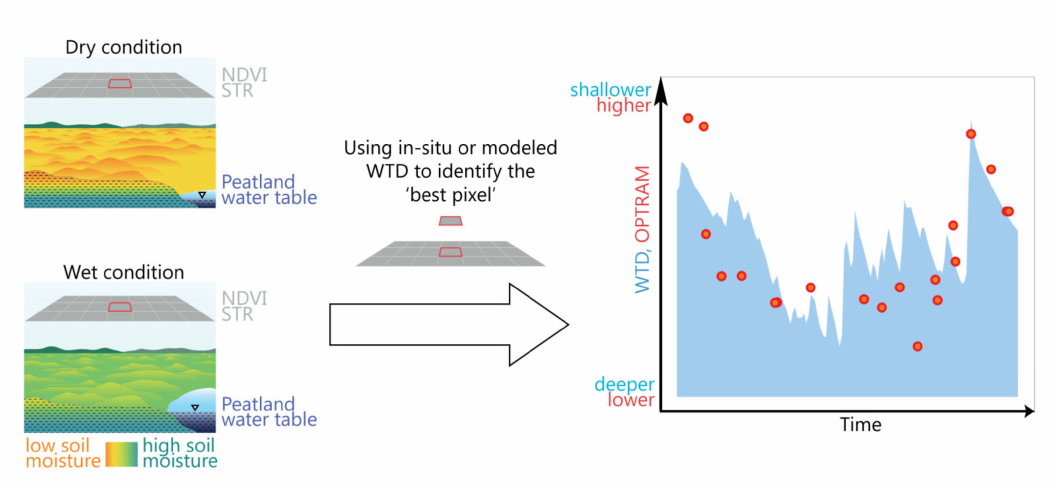
Figure 1. Schematic illustration of the approach proposed in this study. The ‘best pixel’ for the monitoring of water table depth (WTD) fluctuations with the OPtical TRApezoid Model (OPTRAM) index can be localized by WTD data either measured or modeled for a single location. The underlying assumption of this approach is that WTD fluctuations are synchronous in a peatland over several kilometers, while the spatial variability is mainly in the long-term mean value of WTD and the amplitude of fluctuations, both not a ff ecting correlation